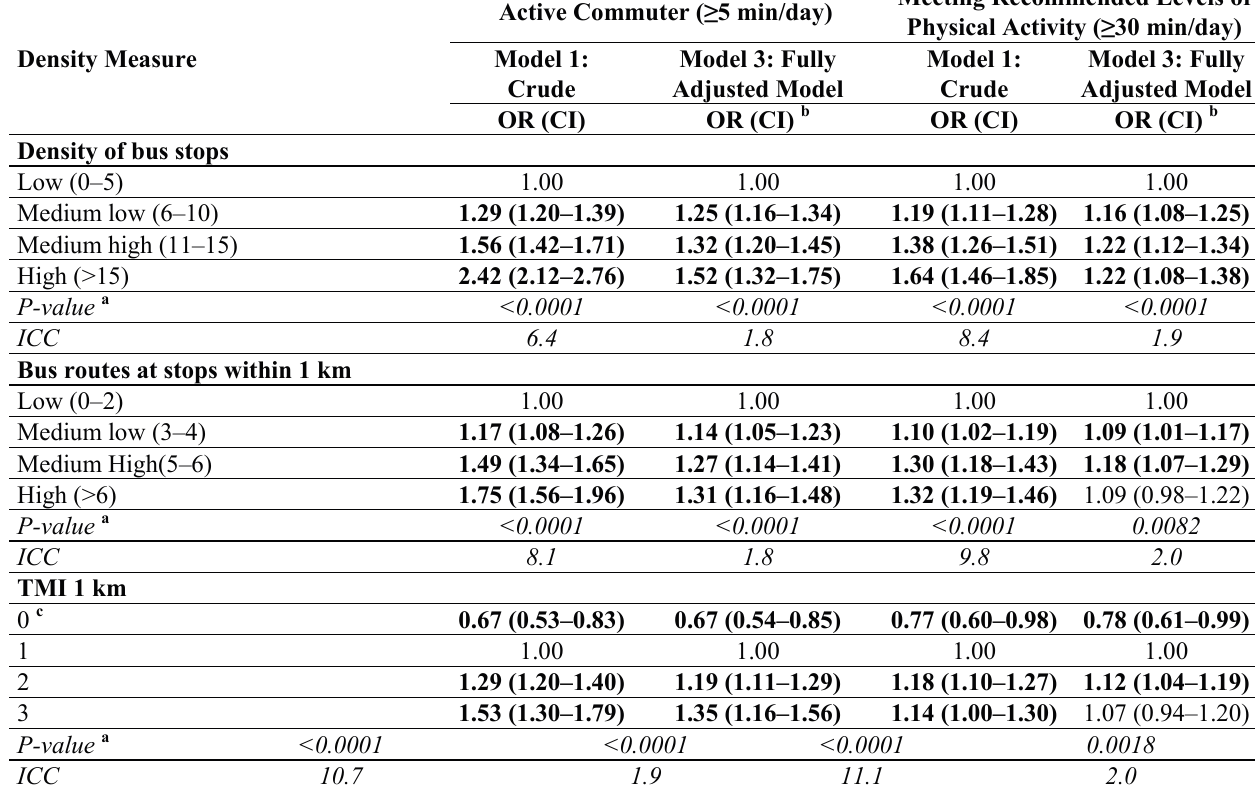
Table 5. Crude and adjusted associations (OR) between objective density measures of public transportation and being an active commuter and meeting recommended levels of physical activity. Between neighbourhood variation is expressed by Intra-class correlation coefficient (ICC). Significant associations are highlighted in bold